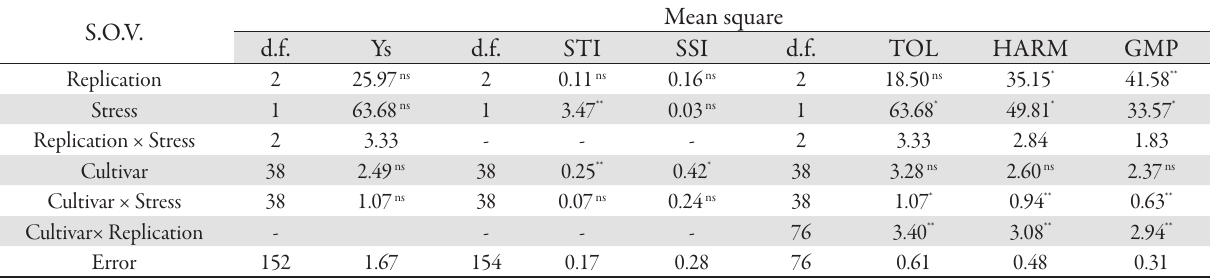
Tab. 3. Mean square for stress yield and drought tolerance indices